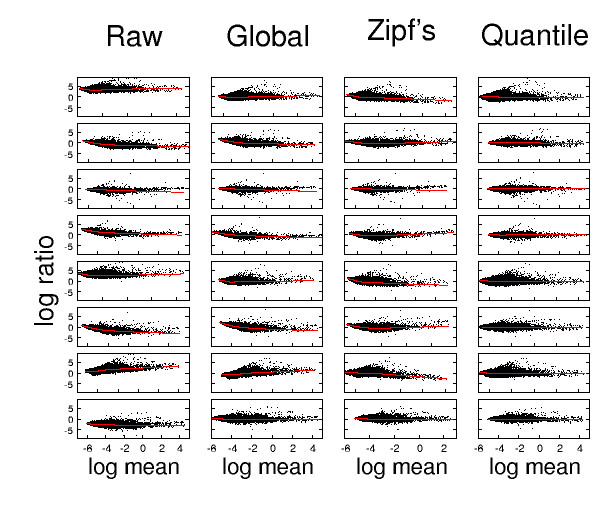
Unigene microarray MA plots. MA plots of Raw Unigene data compared to data normalized with the Global mean, Zipf's, and Quantile methods (columns). Each row of plots represents one pairwise comparison, only 8 of the possible 10 pairwise comparisons of the 5 microarrays used in figure 1are shown. Lowess curves are plotted in red.